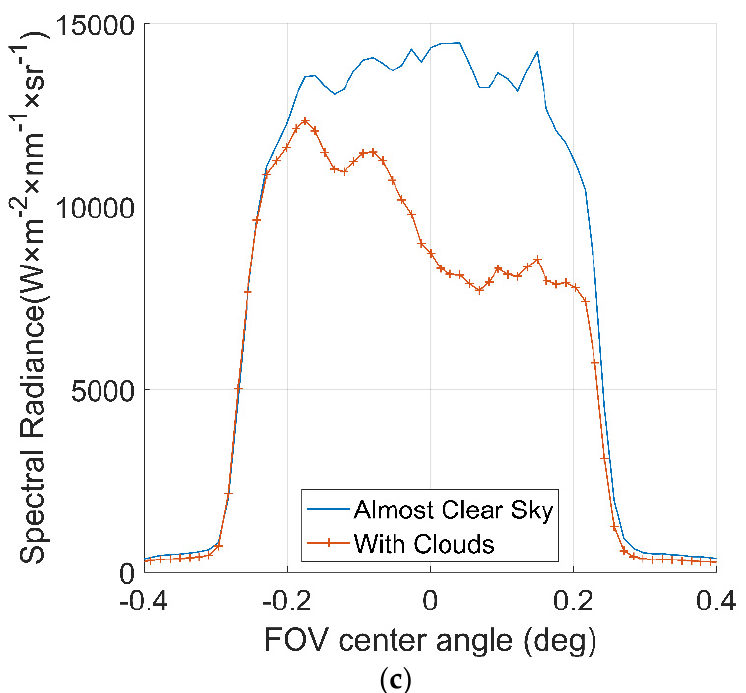
Figure 17. Image when ( a ) the sky is almost clear, ( b ) the clouds appear, and ( c ) the horizontal profile, which near to 758.4 nm.